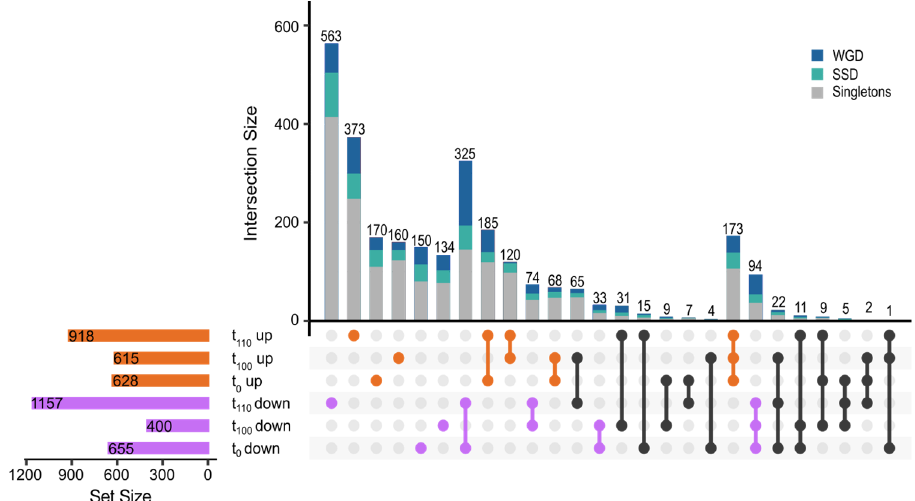
Figure 2. Comparison of de-regulated genes in response to YPL in the yeast Saccharomyces cerevisiae under diversification or adaptive experimental evolution. The UpSet graph shows the number of genes (singletons, WGDs or SSDs) in each category, shared or discordant between each data set. Up-regulated genes shown in orange, down-regulated in violet, and the discordant gene shown in black at different time-points. Graph drawn by the R package UpSetR [33].